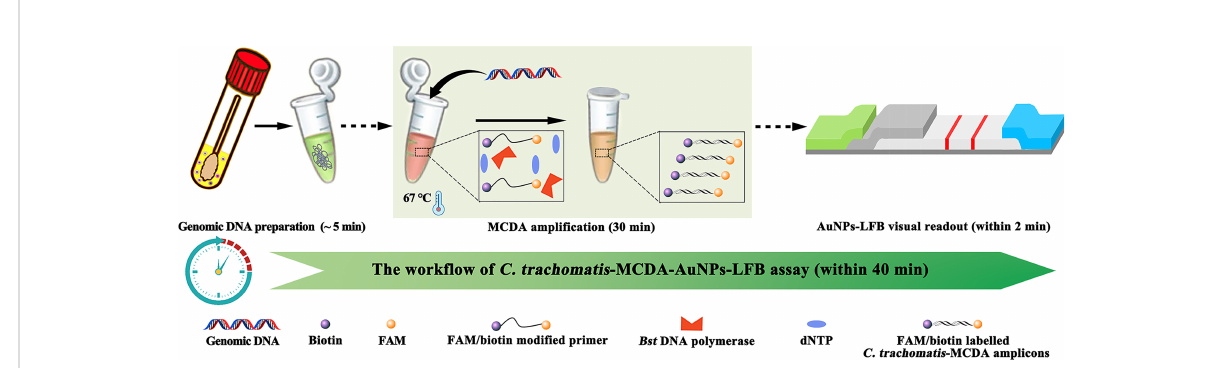
FIGURE 1 C . trachomatis -MCDA-AuNPs-LFB assay work fl ow. The work fl ow includes genomic DNA preparation, MCDA ampli fi cation, and AuNP-LFB visual interpretation, all completed within 40